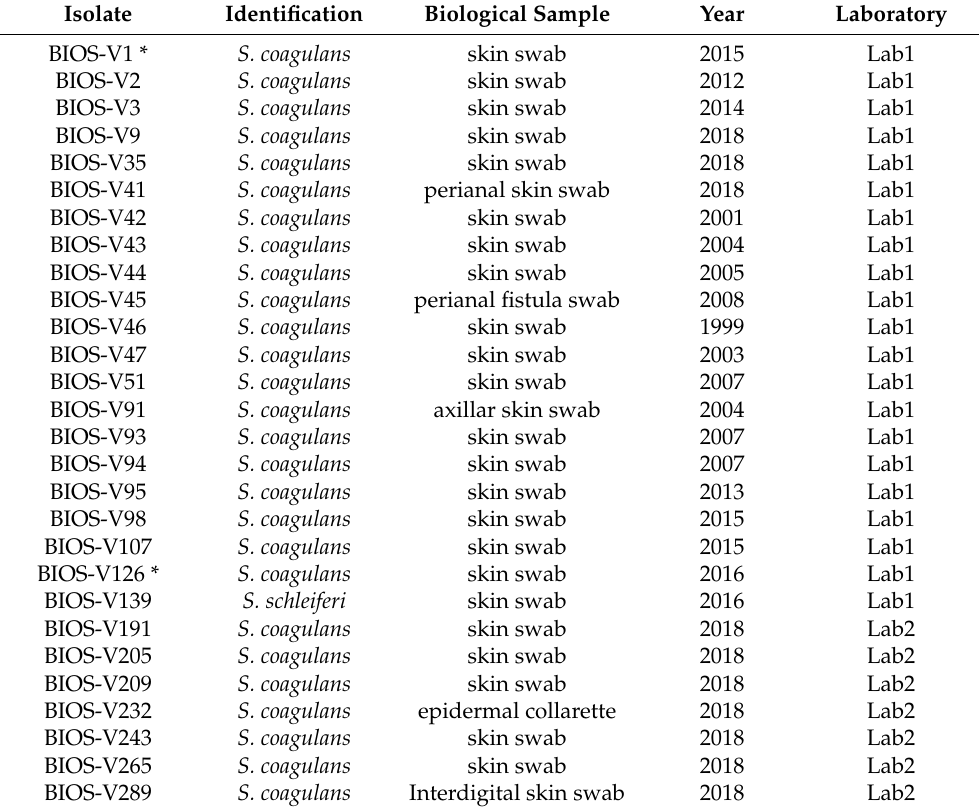
Table 3. Brief description of the S. coagulans ( n = 27) and S. schleiferi ( n = 1) isolates associated with canine skin